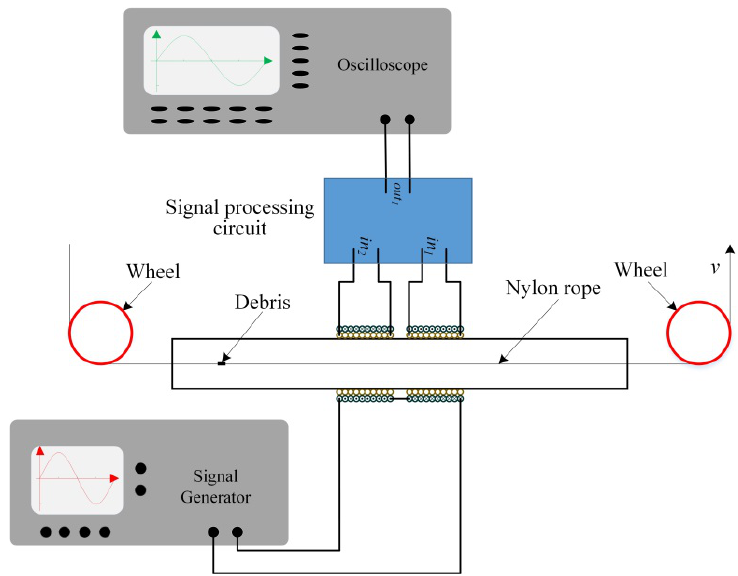
Figure 6. Schematic diagram of the experimental platform.